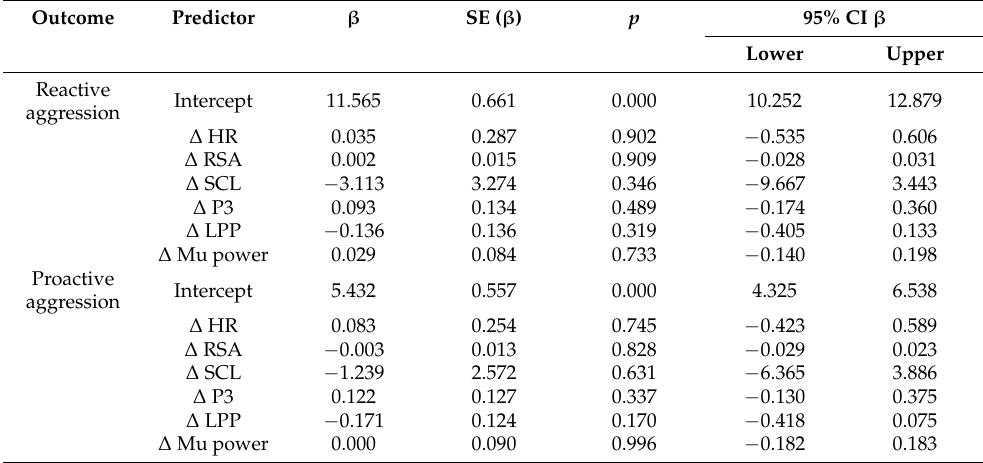
Table 3. Results of pooled regression models predicting reactive and proactive